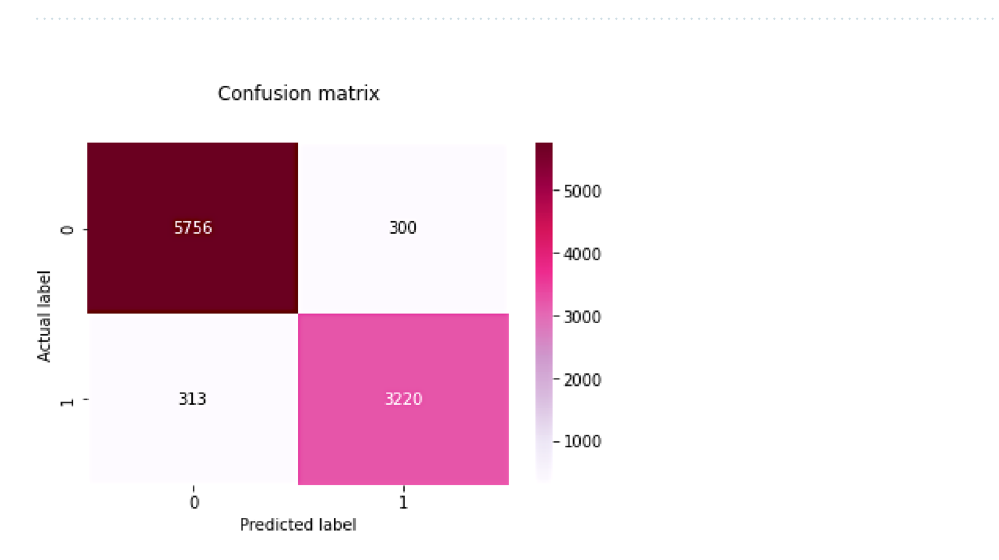
Figure 9. Learning rate graph of the ResNet-32 network.